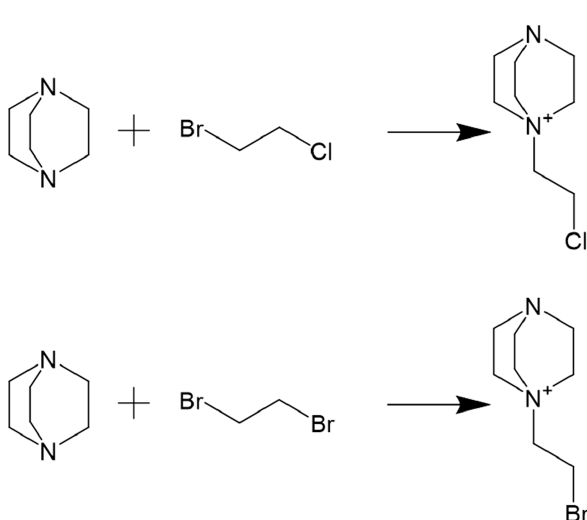
Figure 1. Structural plots of organic ligands.